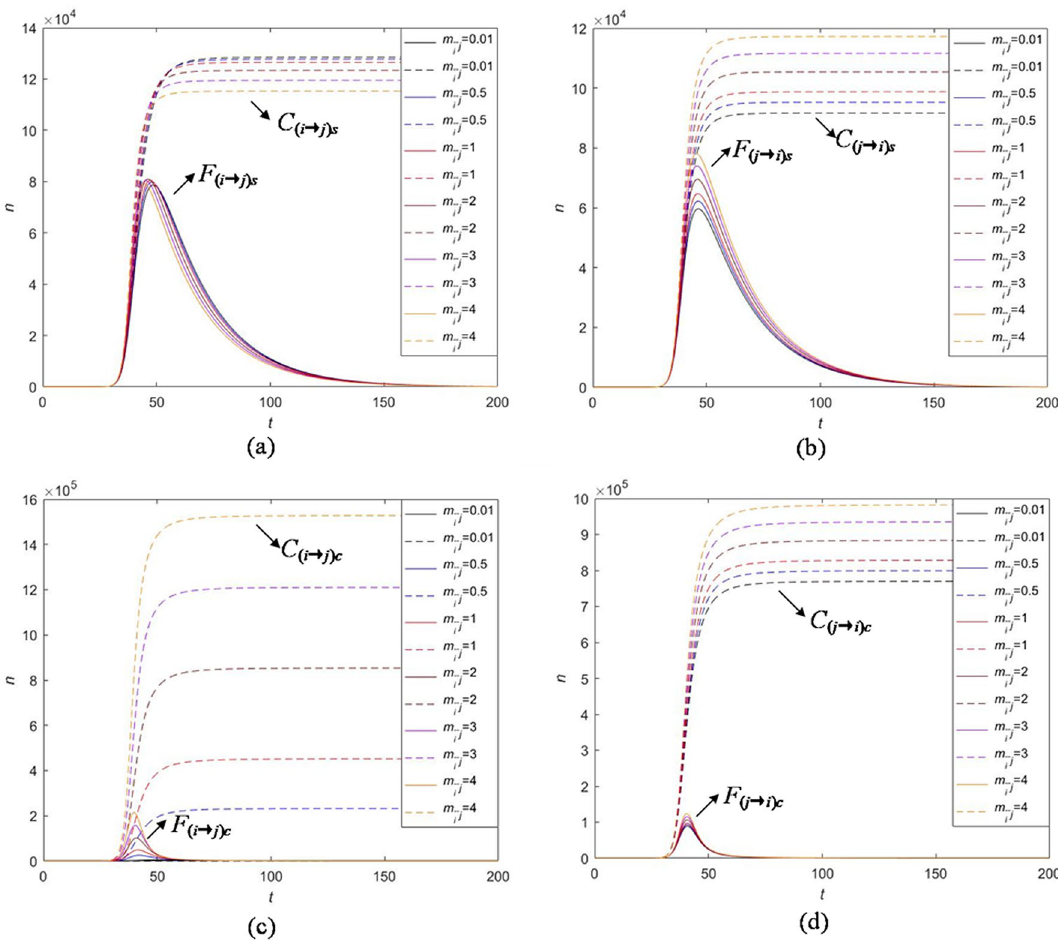
Figure 14. Numerical experiments on the effect of parameter m ¯ ij on cross-transmission with strong attraction and continuous attraction: ( a ) strong attraction from information i to information j ; ( b ) strong attraction from information j to information i ; ( c ) continuous attraction from information i to information j ; ( d ) continuous attraction from information j to information i